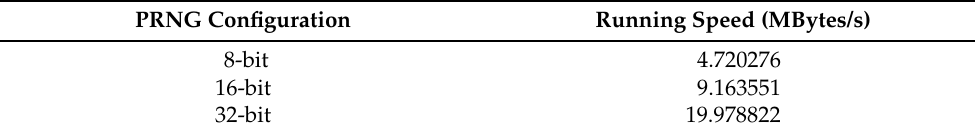
Table 6. Execution time to generate 1,000,000 pseudorandom numbers by using the proposed PRNG considering the three